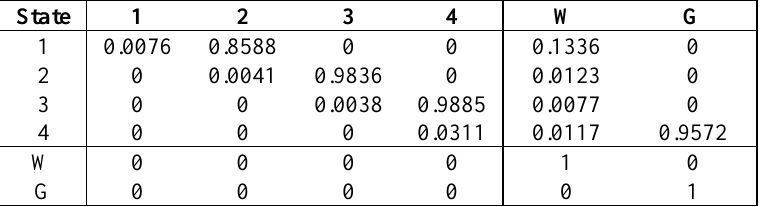
Table 4. The initial transition probability matrix